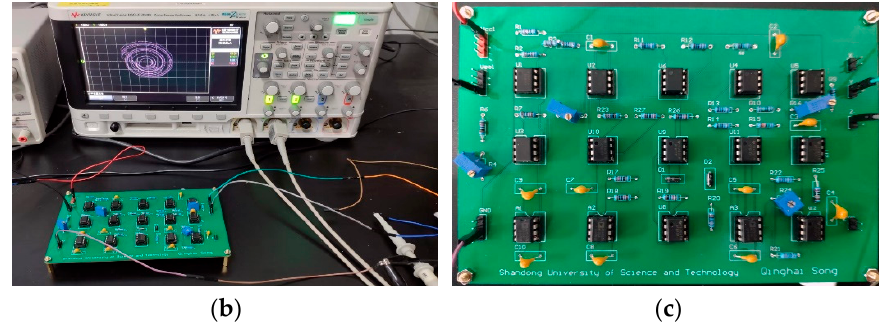
Figure 18. The experimental results of the memristive chaotic system from the physical circuit: ( a ) the typical chaotic attractor from the oscilloscope; ( b ) experimental platform; ( c ) the corresponding circuit board.